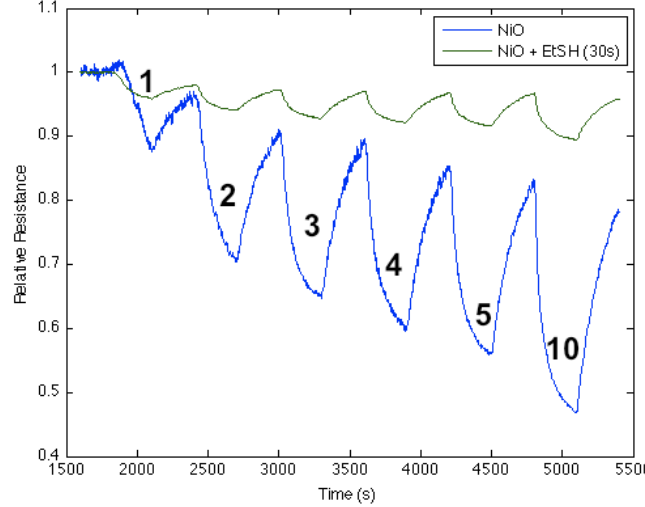
Figure 10. Response of ethanethiol-treated nickel oxide nanostructure-deposited porous silicon (PS) interface to NH exposure for 30 s ( green line ), and exposure only to nickel 3 oxide ( blue line ). The thiol-treated NiO-deposited interface is more acidic than the NiO-treated PS acidic sites (Figure 1) after a 30 s